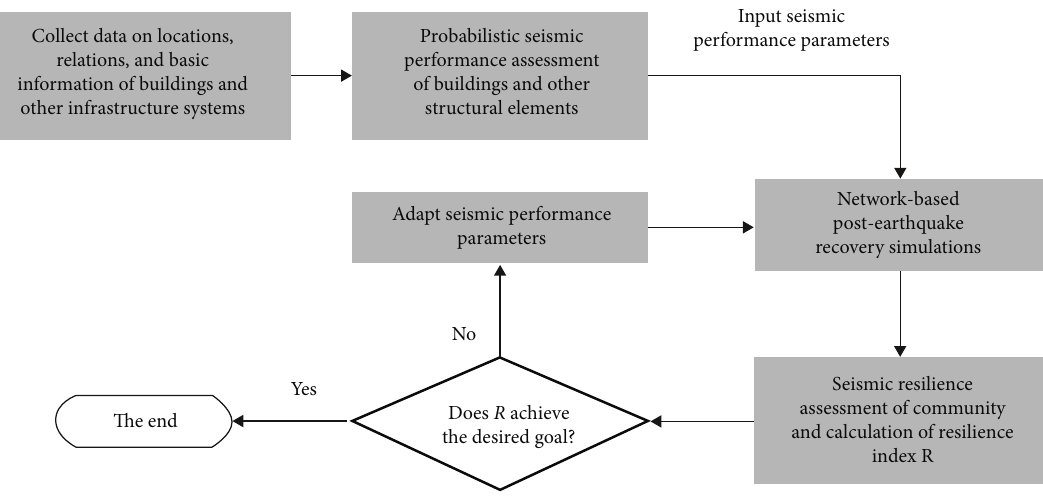
Figure 2: The flowchart of the framework [30].